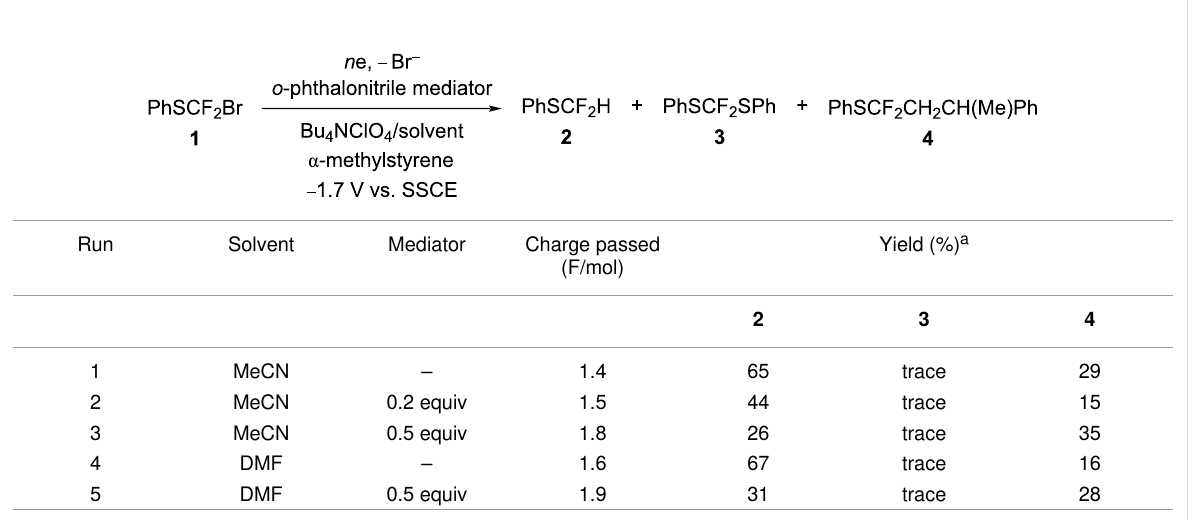
Table 2: Indirect cathodic reduction of compound 1 using o -phthalonitrile as mediator in the presence of α